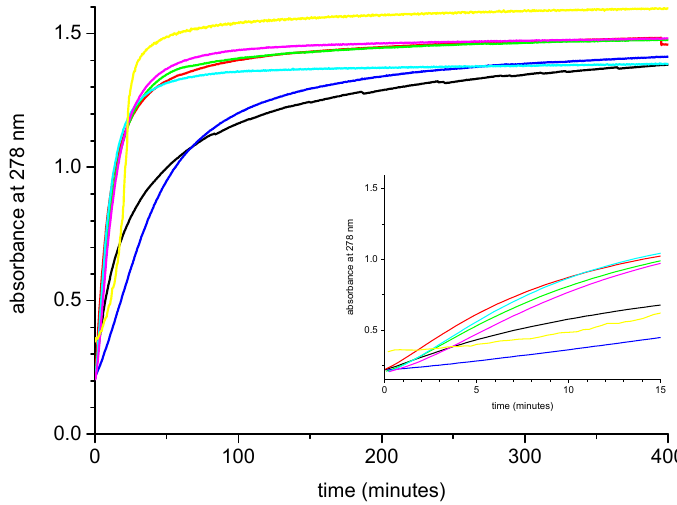
Figure 3. Examples of the absorbance at 278 nm recorded during the homocoupling reaction of 150 µ M 1 in water with pH 9 borate buffer (10 mM) and catalyst Pd-PPy-PS (1.8 µ M Pd) over the course of 7 h at 70 ◦ C in the presence of 0 M (black), 0.05 M (red), 0.1 M (green), 0.25 M (blue), 0.5 M (cyan), 1 M (magenta), and 4.4 M (yellow) of NaCl. The first 15 min of the reaction are also shown as inset.